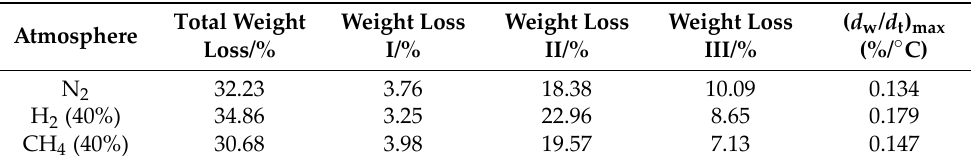
Figure 2. TG − DTG curves of coal pyrolysis under different heating rates in N 2 , H 2 (40%), and CH 4 (40%): ( a )TG curves and; ( b ) DTG curves. Table 2. Pyrolysis characteristics of different pyrolysis stages.